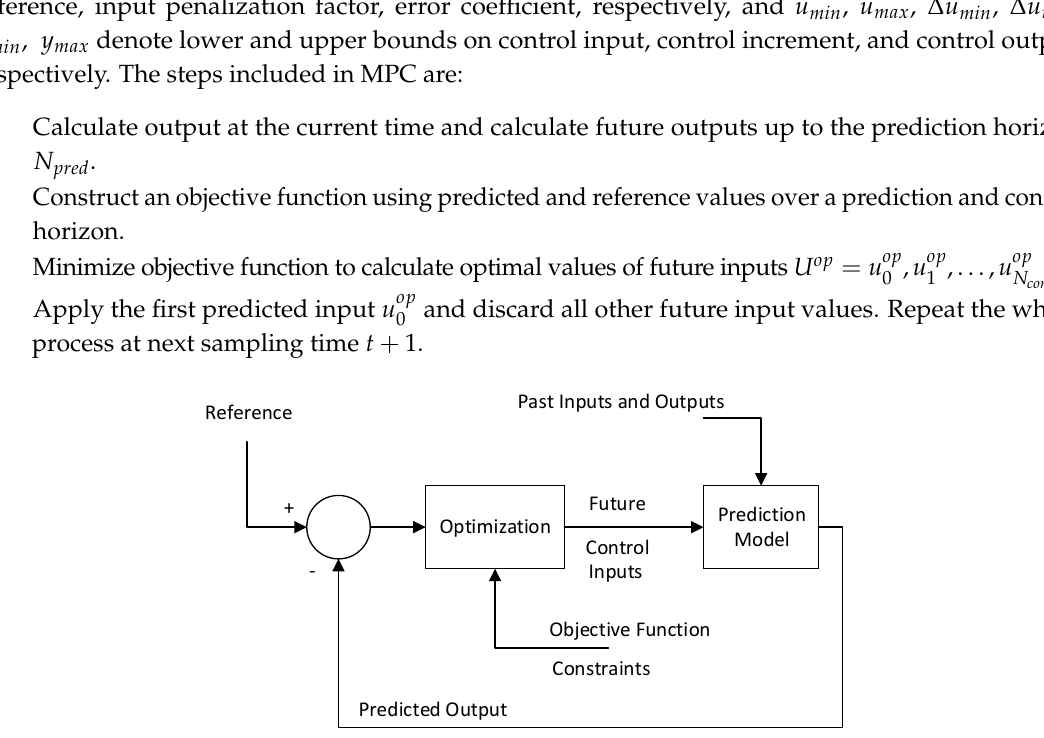
Figure 1. The Basic Structure of